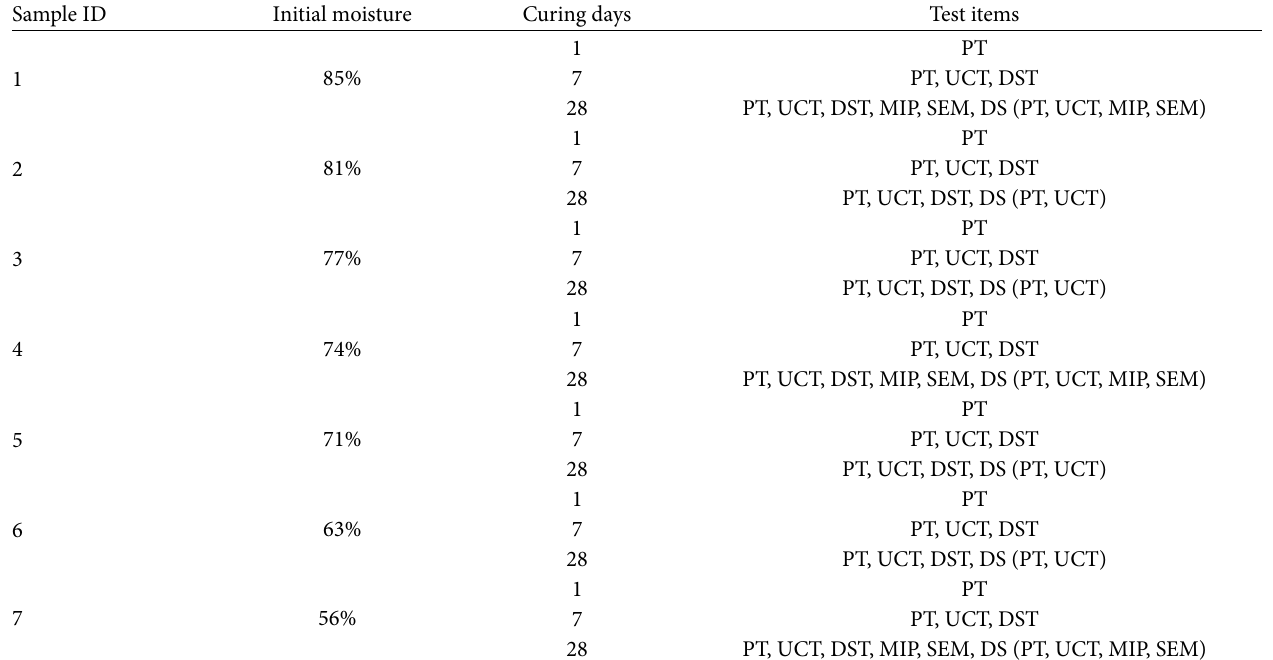
Table 2: Experimental design of this study.